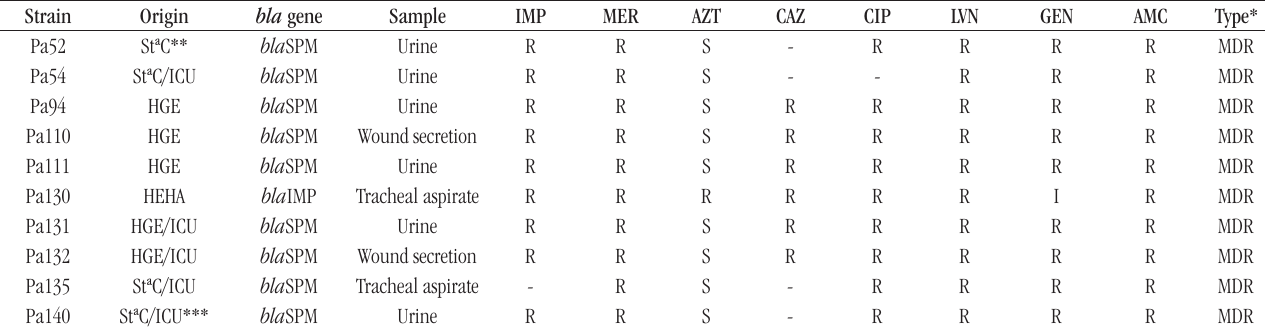
taBLE − Resistance profile of M β L-positive Pseudomonas aeruginosa strains from Alagoas